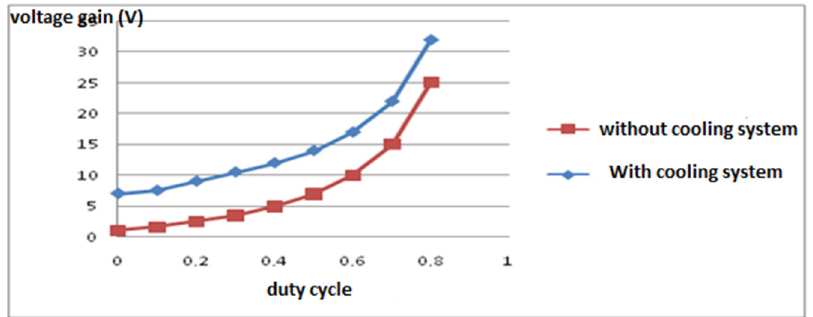
Figure 15. Voltage gain with and without a cooling system .